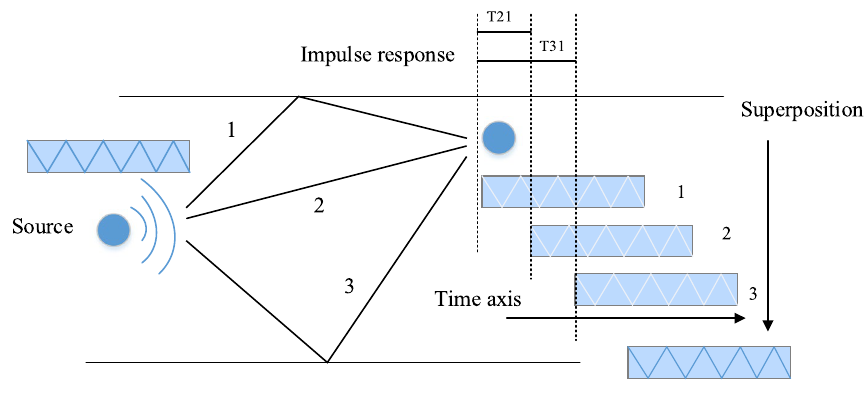
Fig. 1 Physical model of sound line